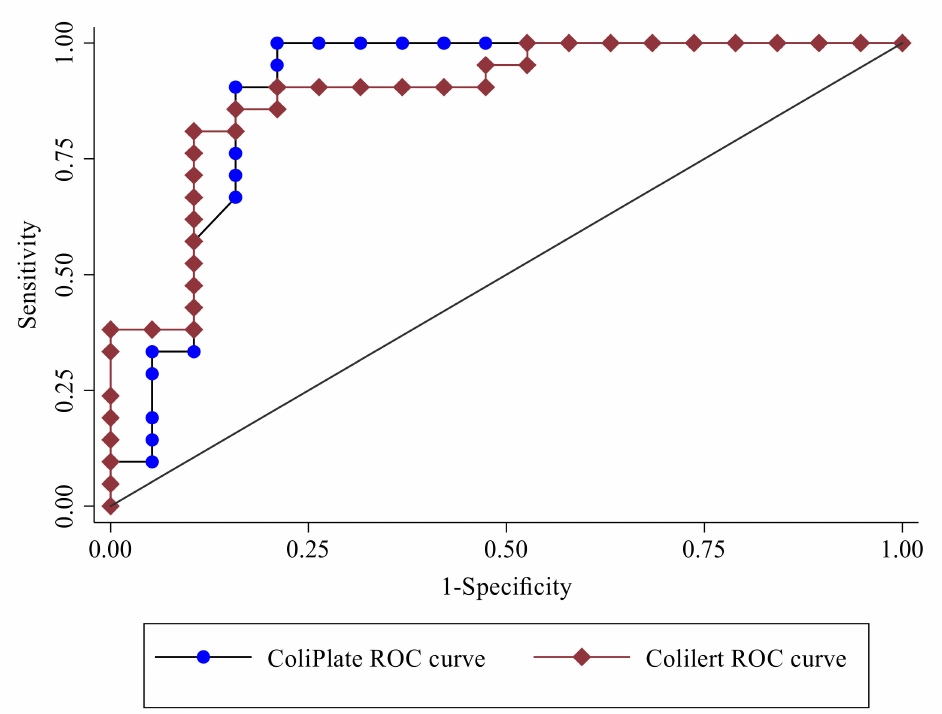
Figure 3. Receiver operating characteristic (ROC) curves and the area under the curve (AUC) for the ColiPlate (blue) and Colilert (red) most probable number (MPN) methods used in this study for predicting > 100 colony-forming units of E. coli obtained by membrane filtration with mTEC